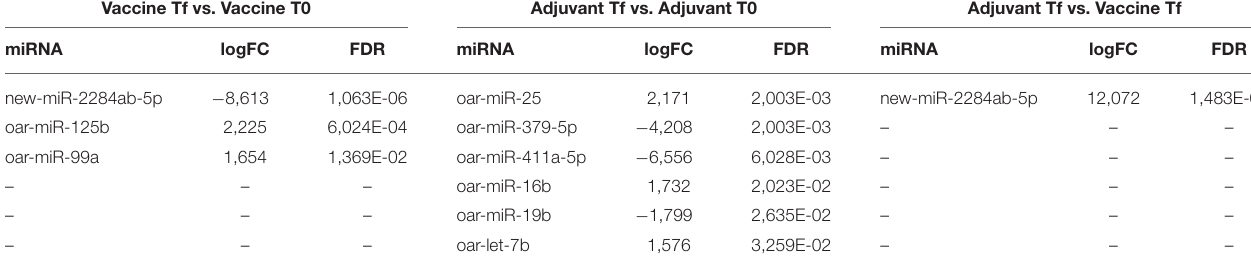
TABLE 2 | List of differentially expressed miRNAs detected by edgeR with a FDR-adjusted p -values of ≤ 0.05. Vaccine Tf vs. Vaccine T0